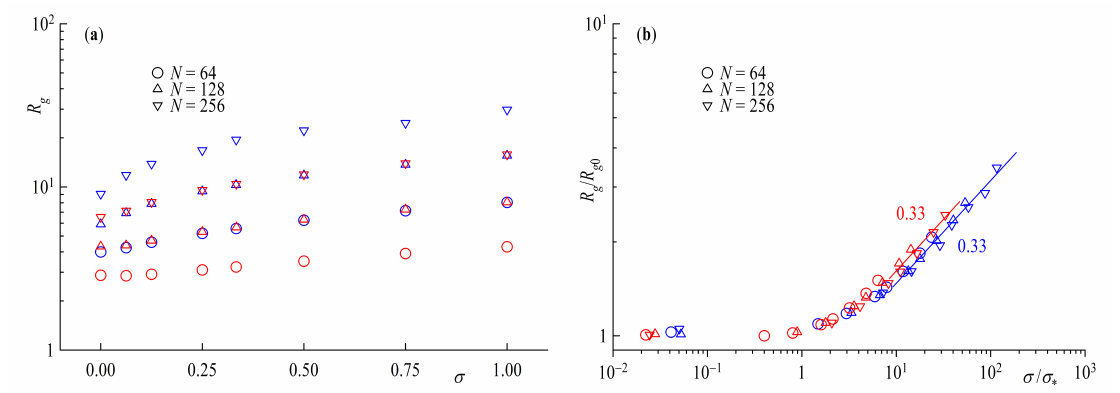
Figure 4. ( a ) Radius of Gyration R g as a function of surface coverage σ and ( b ) R g scaled by a free infinitely diluted chain value R g 0 as a function of surface overlap concentration σ ∗ . Straight lines indicate power law fits with scaling exponents shown next to the line. Red symbols are rings and blue for